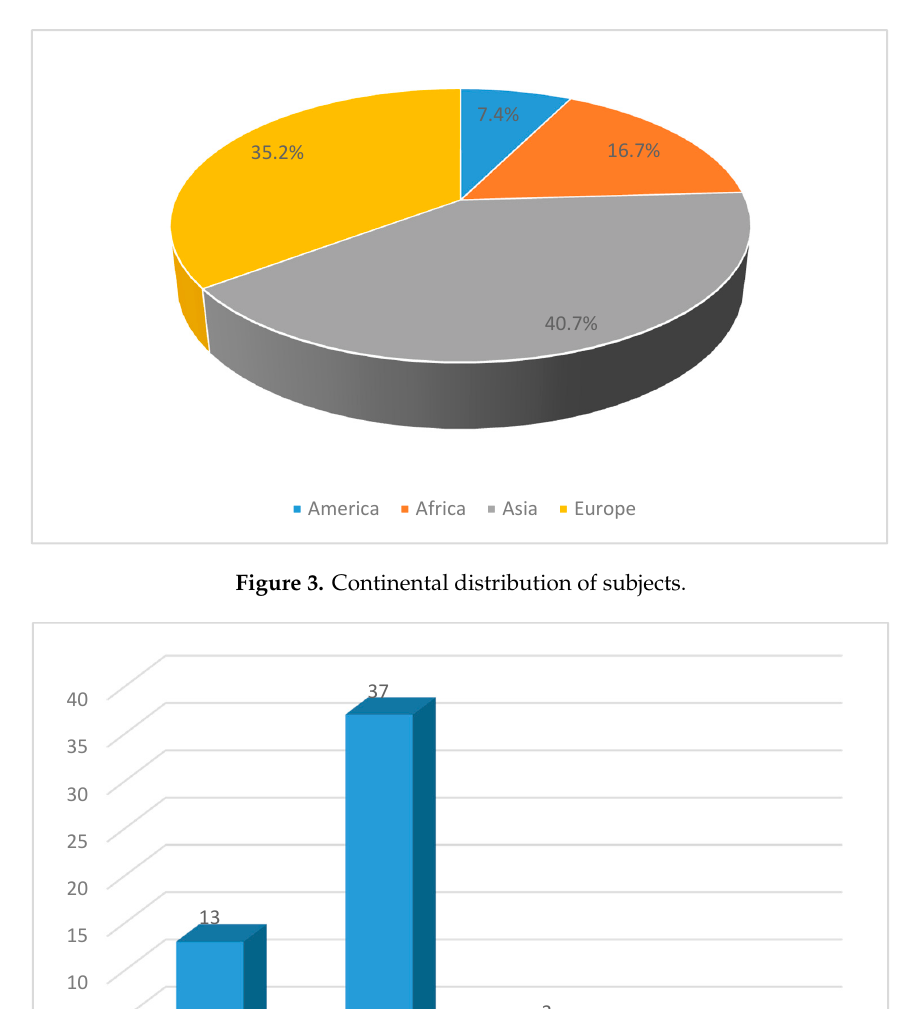
Table 6. Sub-group analysis for women.